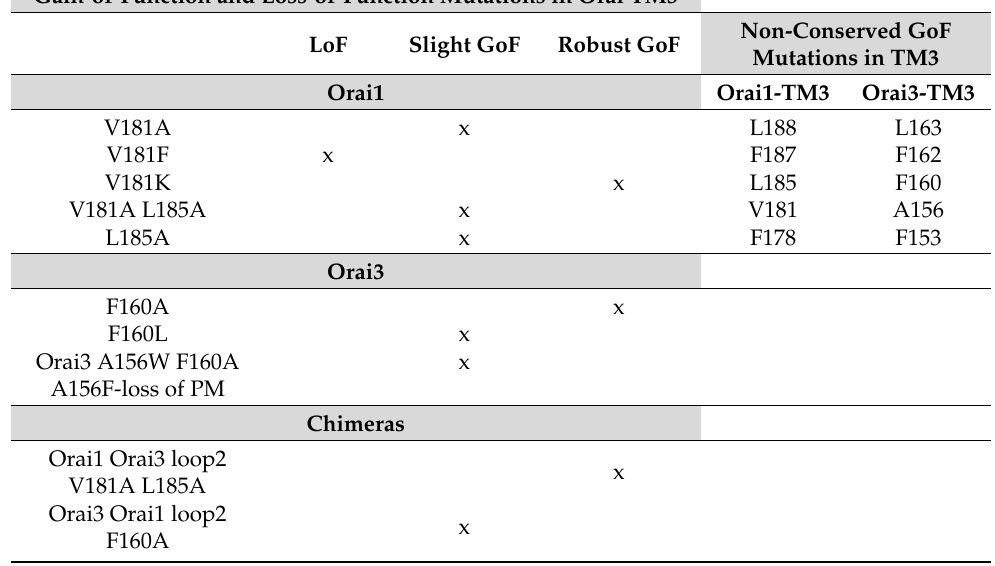
Table 5. Gain-of-function and loss-of-function mutations and isoform-specific differences of gating checkpoints in Orai